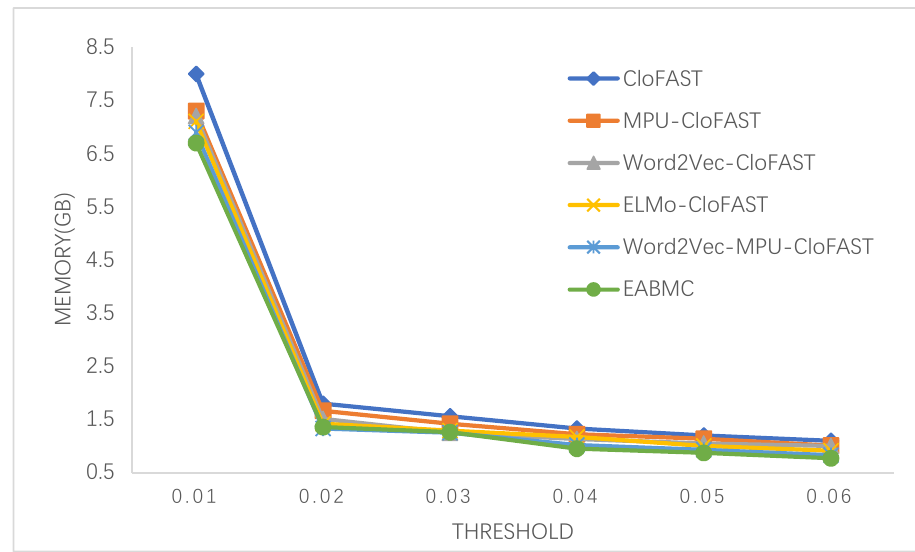
ff erent algorithms.